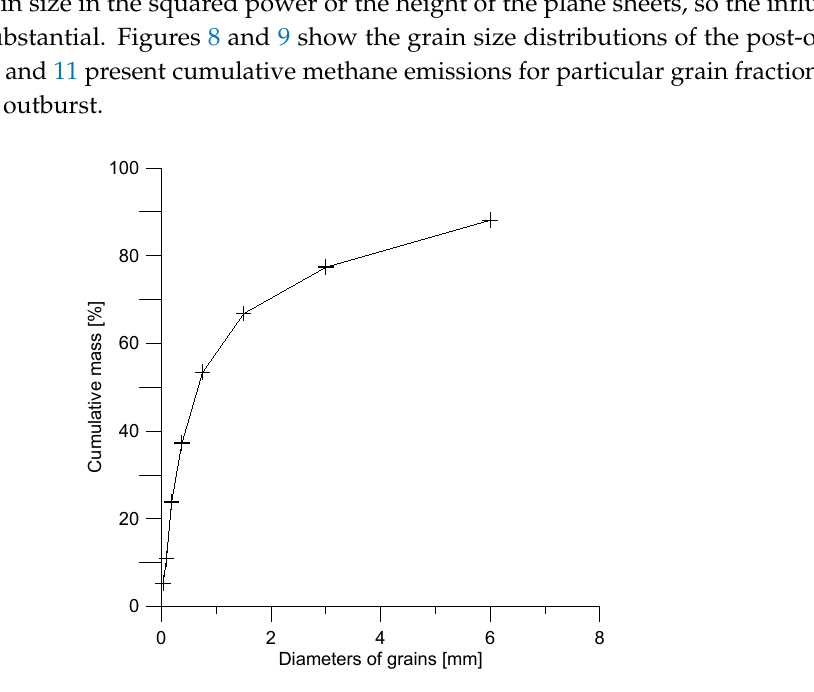
Figure 8. The grain size distribution of the post-outburst masses—Zofiówka coal mine.